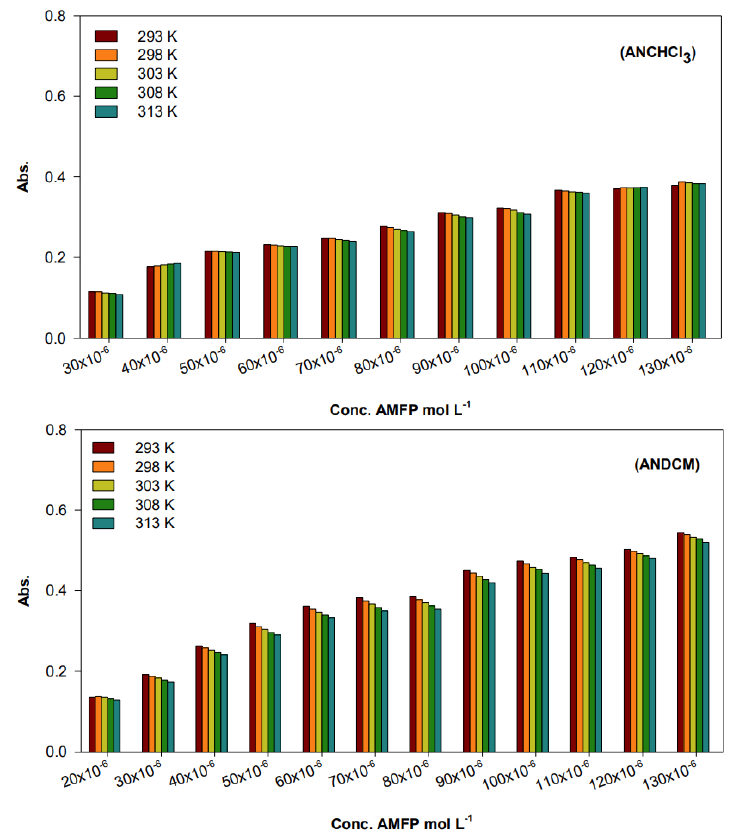
Figure 7. Effect of temperature on the absorbance of the AMFP – DDQ CT complex in different solvents systems.